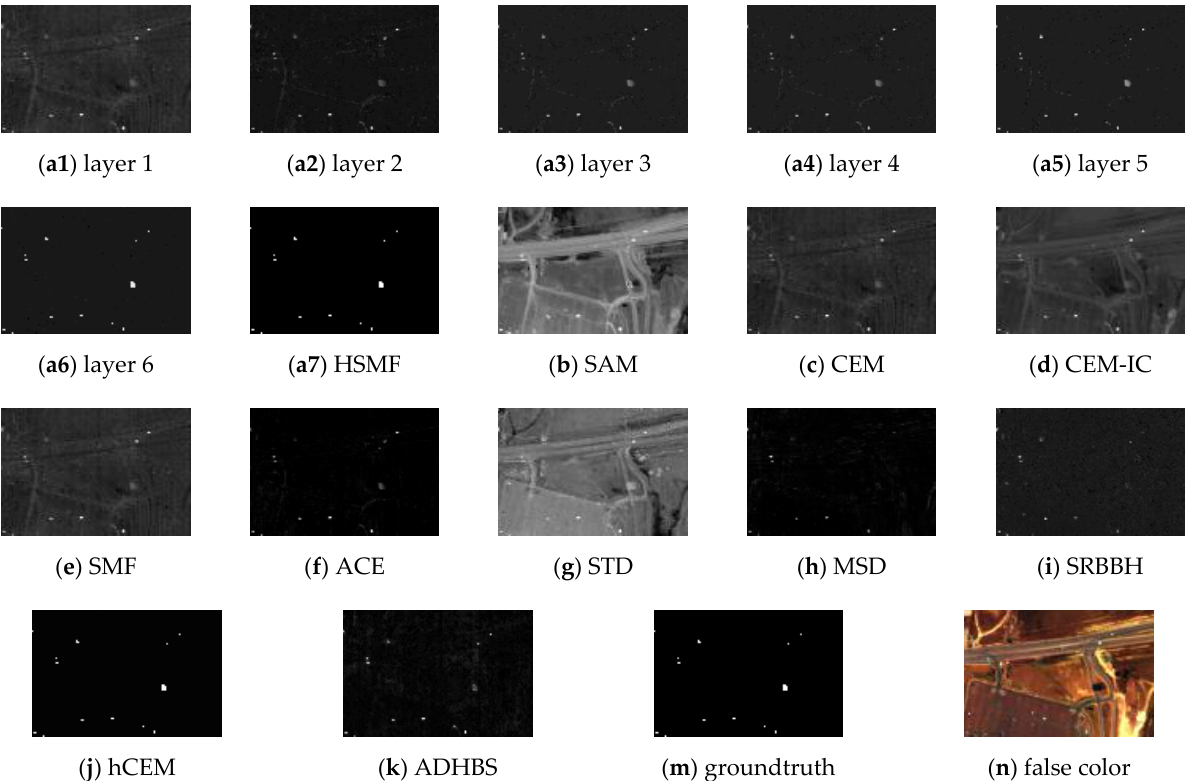
Figure 7. Detection results of different algorithms on the Urban data. ( a1 – a6 ): Results of HSMF for the first to the sixth layers. ( a7 ): The final result of HSMF. ( b – k ): Results of SAM, CEM, CEM-IC, SMF, ACE, STD, MSD, SRBBH, hCEM, and ADHBS. ( m ): The groundtruth information. ( n ) The false color image (bands 7, 48, 144). Table 3. AUC values and AUC values at lower FAR of all detectors for the Urban data.